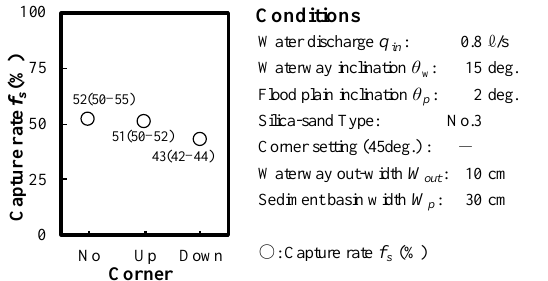
Figure 8. Effects of changes in the supply flow q in rate on the sediment catch rate in the sediment retarding basins.